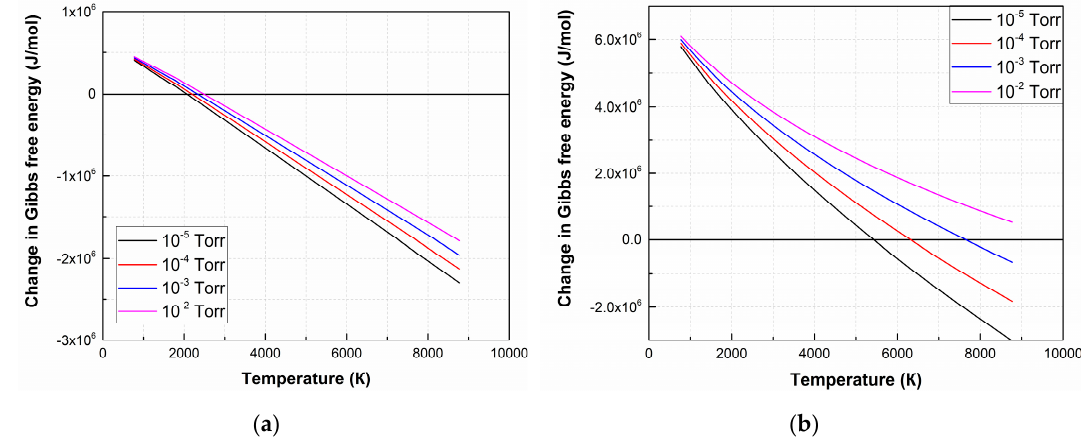
Figure 2. Δ G temperature dependences of the decomposition reactions of LiNbO 3 into Li 2 O and Nb 2 O 5 (4) ( a ) and individual elements (7) ( b ) at different oxygen pressures.